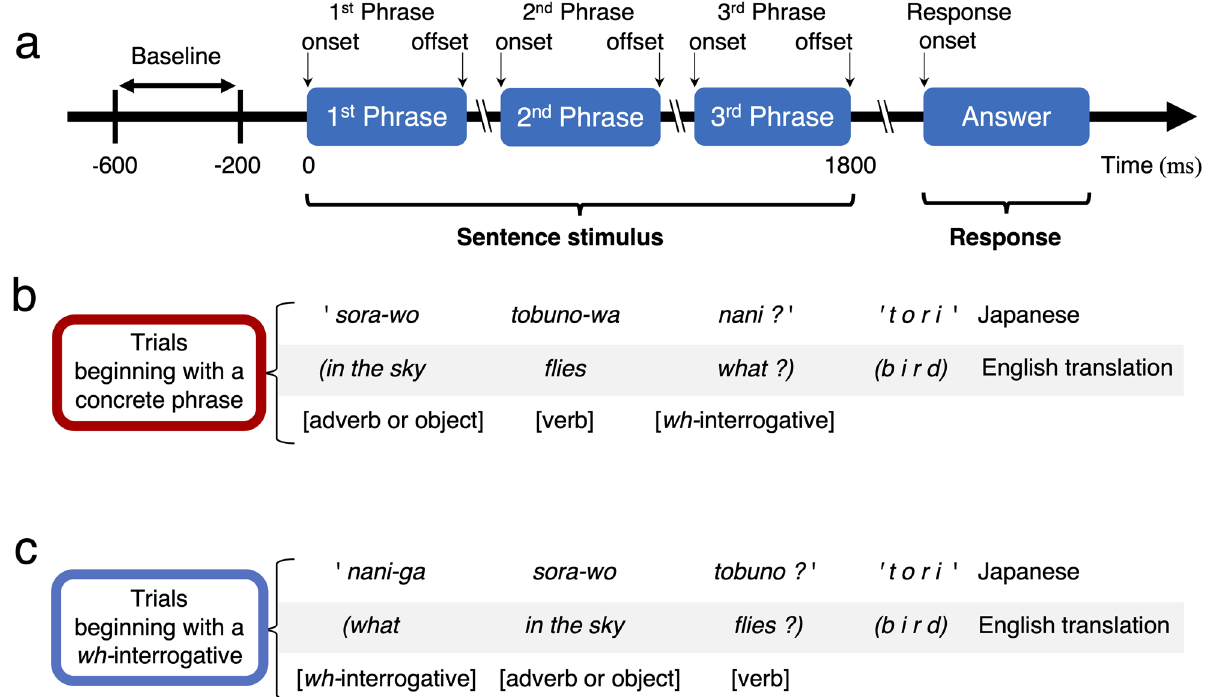
Figure 2. Spoken sentence stimuli used for measurement of task-related high-gamma modulations. ( a ) Patients were instructed to listen to a series of sentence questions and overtly provide a relevant answer to each item during extraoperative intracranial EEG recording. The response time was defined as the period between sentence offset (i.e., 3rd phrase offset) and response onset. A 400-ms resting period, at 200–600 ms before the stimulus onset, was treated as the baseline period for measurement of task-related high-gamma modulations. We have prepared 192 sentence stimuli, in total, for the present study. ( b ) Ninety-six stimuli were characterized by the following order of three phrases: [adverb or object], [verb], and [what, when, or where]. Each of the 96 sentence stimuli begins with a concrete word; [adverb or object] starts with a concrete noun because an adposition (e.g., ’-o’) follows a noun in Japanese but precedes in English (e.g., ’in the’). ( c ) Each of the other 96 sentence stimuli (each with the same semantic context as one of the former 96) begins with a wh-interrogative and is characterized by the following order of three phrases: [what, when, or where], [adverb or object], and [verb]. A given patient was assigned 48 question stimuli beginning with a concrete phrase and 48 beginning with a wh-interrogative; thereby, none of the assigned 96 questions shared the same semantic context. Sentence types were counterbalanced across false discovery rate [FDR]-adjusted p = 0.006). Likewise, the magnitude of high-gamma suppression at the left posterior IFG was maximized at 260 ms after the 1st phrase offset (Fig. 4b; maximum suppression = − 6.2%; 95% CI − 8.3 to − 4.2%; FDR-adjusted p = 0.006). The maximum high-gamma suppression at the left anterior MFG (Fig. 4c; maximum suppression = − 7.2%; 95% CI − 9.6 to − 4.9%; FDR-adjusted p = 0.007) and left orbitofrontal region (Fig. 4d; maximum suppression = − 11.5%; 95% CI − 16.7 to − 5.4%; FDR-adjusted p = 0.010) took place at 110 ms and 110 ms after the 2nd phrase offset, respectively. Left prefrontal high-gamma activity subsequently rose and maximized around or after the 3rd phrase offset (Fig. 4). The left posterior prefrontal high-gamma activity reached the maximum earlier than the left anterior. Specifically, the magnitude of high-gamma augmentation at the left posterior MFG reached the statistical sig- nificance at 500 ms before the 3rd phrase offset and the maximum at 190 ms before the 3rd phrase offset (Fig. 4a; maximum augmentation = + 12.9%; 95%CI + 8.5 to + 18.2%; FDR-adjusted p = 0.005). Likewise, high-gamma augmentation at the left posterior IFG reached the statistical significance at 310 ms before the 3rd phrase offset and the maximum at 310 ms after the 3rd phrase offset (Fig. 4b; maximum augmentation = + 15.1%; 95% CI + 9.2 to + 22.2%; FDR-adjusted p = 0.004). High-gamma augmentation at the left anterior MFG reached the statistical significance and maximum at 720 ms and 790 ms after the 3rd phrase offset, respectively (Fig. 4c; maximum augmentation = + 5.2%; 95% CI + 2.6 to + 7.7%; FDR-adjusted p = 0.007). The magnitude of left orbitofrontal high- gamma augmentation failed to reach the significance but reached the maximum at 380 ms after the 3rd phrase offset (Fig. 4d; maximum augmentation = + 5.5%; 95% CI − 0.1 to + 12.7%; FDR-adjusted p = 0.13). Compared to the left anterior, the left posterior prefrontal high-gamma activity rose earlier (Fig. 4). The rate of increase of high-gamma activity, as quantified by a slope, was maximized exactly at the 2nd phrase offset at the left posterior MFG (+ 25%/s; 95% CI + 14 to + 36%; Supplementary Fig. S1) and 220 ms after the 2nd phrase offset at the left posterior IFG (+ 22%/s; 95% CI + 11 to + 33%). Likewise, that was maximized at 410 ms after the 2nd phrase offset at the left anterior MFG (+ 14%/s; 95% CI + 10 to + 18%) and 390 ms after the 2nd phrase offset at the left orbitofrontal region (+ 21%/s; 95% CI + 13 to + 29%).